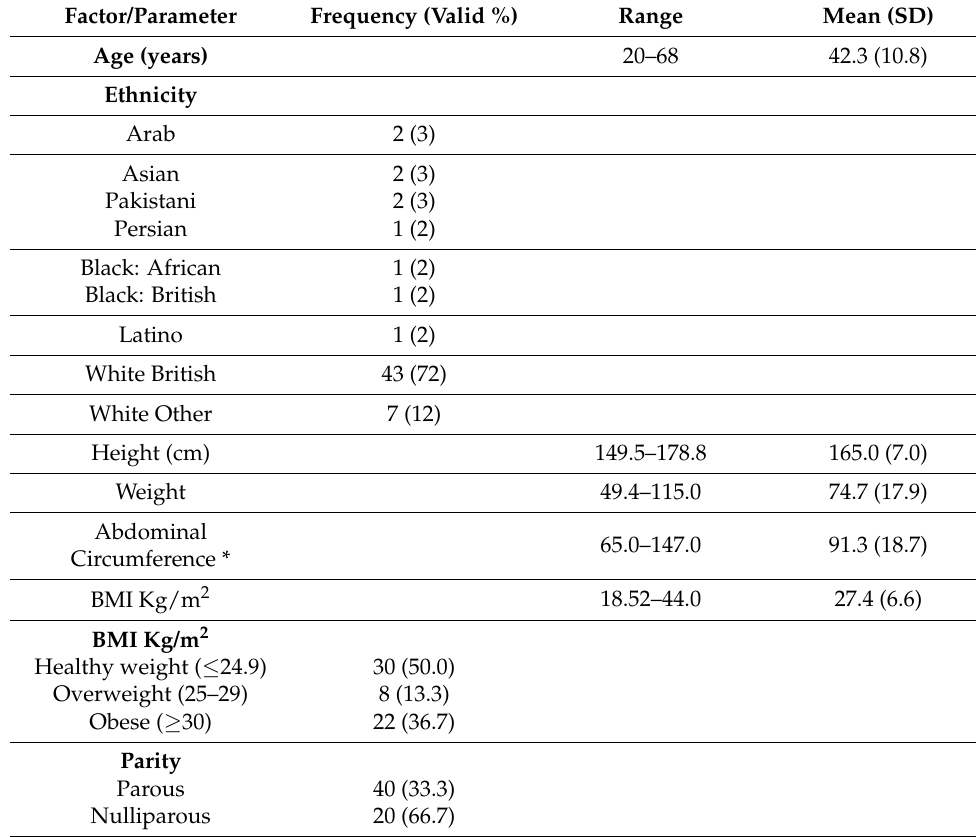
Table 1. Participant